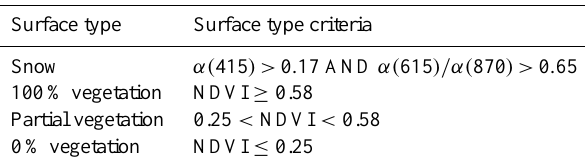
Table 1. Albedo and NDVI thresholds for determining surface